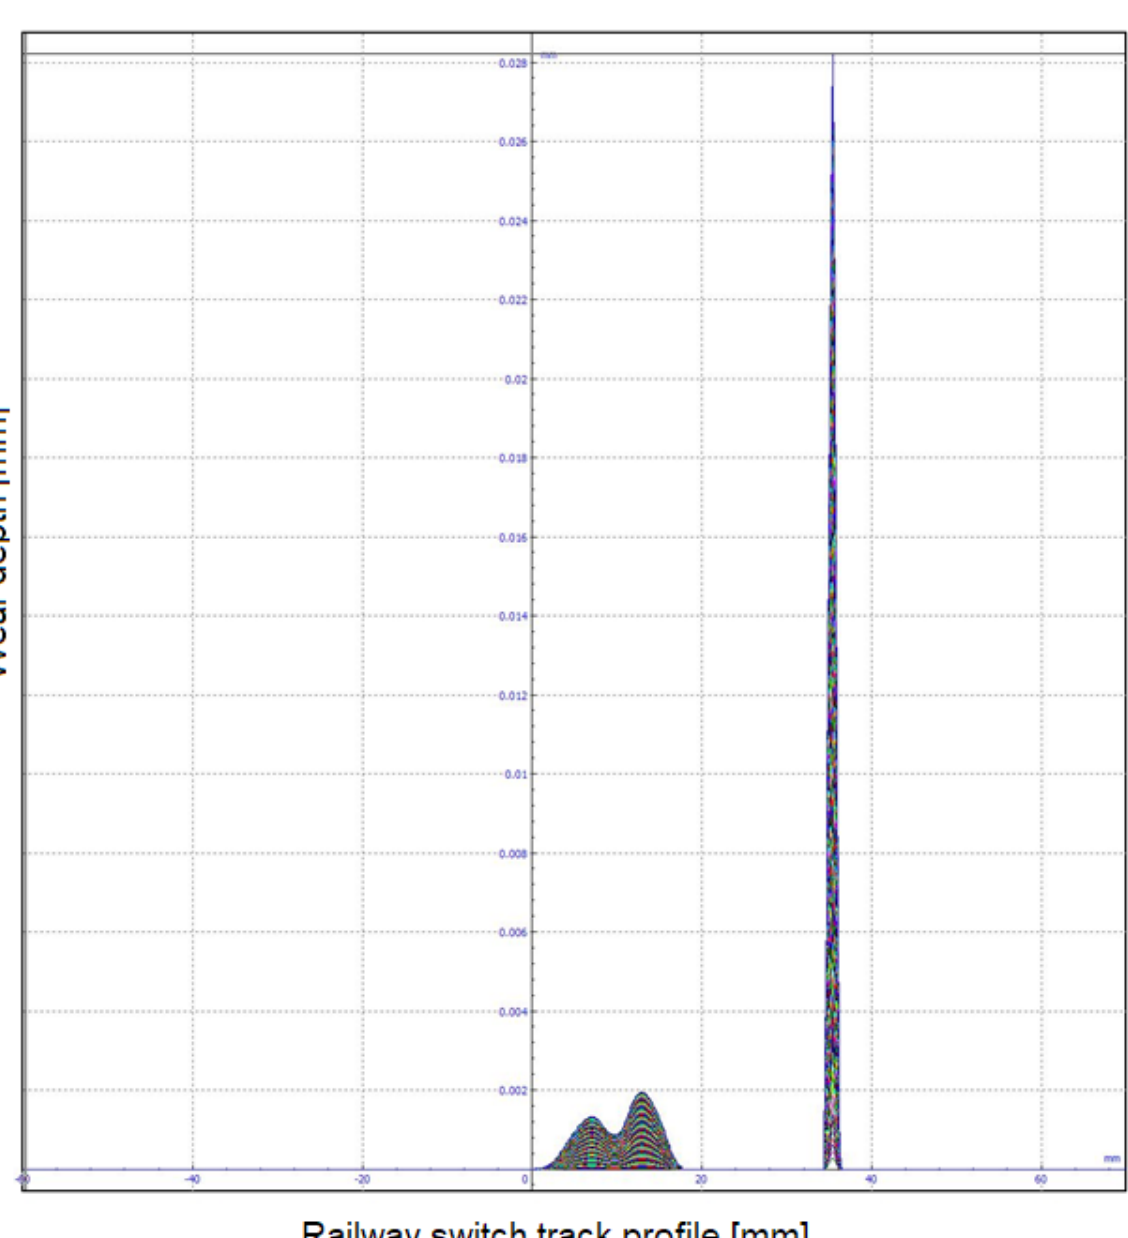
Figure 48. Rail wear for a straight track without a turnout with constant stiffness obtained at 300 km/h.